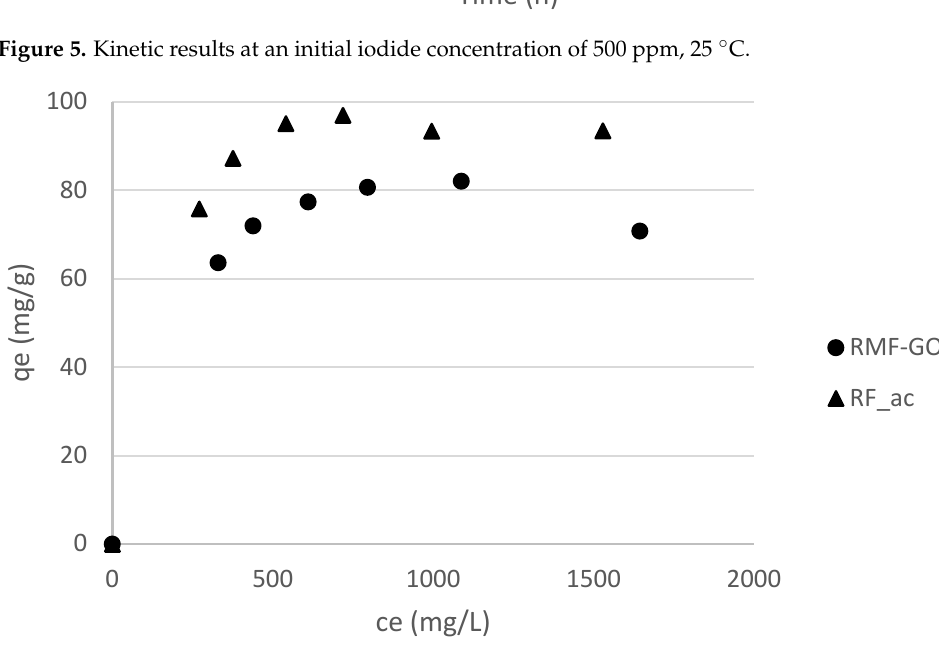
Figure 6. Equilibrium isotherms, 25 ◦ C. The isotherms were measured in the 0–1700 ppm equilibrium concentration range at 25 ◦ C. In the case of RMF-GO there is an outlier equilibrium point at the highest equi- librium concentration of 1644 mg/L, which leads to the decreasing trend of the isotherm, phenomenon encountered previously in literature